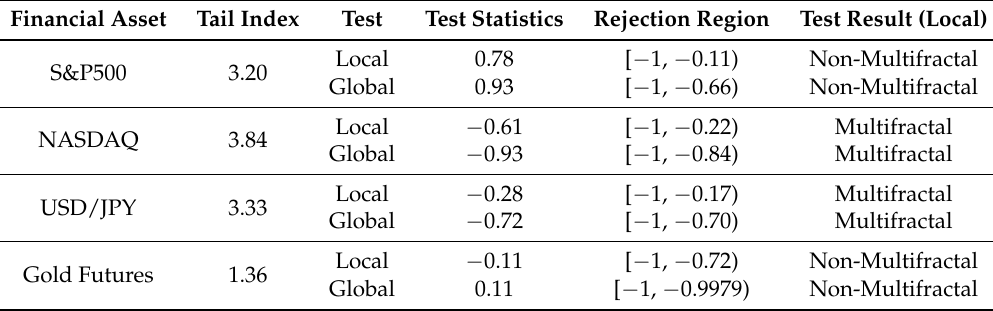
Table 7. Test results among different financial assets (4 March 1988–3 September